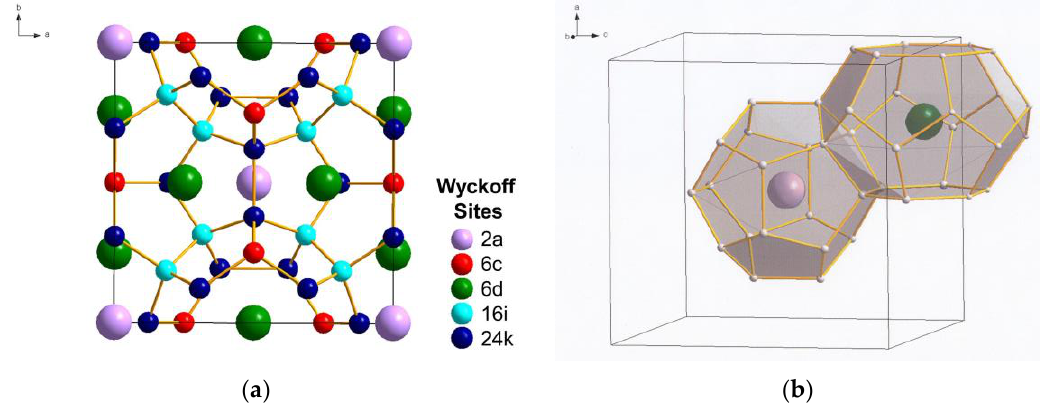
Figure 1. Crystal structure of Type I C 46 clathrate (SG: Pm 3 n , No. 223): ( a ) unit cell and ( b ) cage structure depicting the two building polyhedrons consisting of two nano-cages of 20 atoms (C 20 cage) and 24 atoms (C 24 cage). The nano-cages are formed of carbon atoms occupying the following Wyckoff positions identified with different colors: C(1) 6c (red), C(2) 16i (light blue), and C(3) 24k (dark blue). The Li guest atoms inserted inside the cages occupy the positions Li(1) 2a (light purple) and Li(2) 6d (green). (Color online: version: the different Wyckoff positions are identified with different colors.)